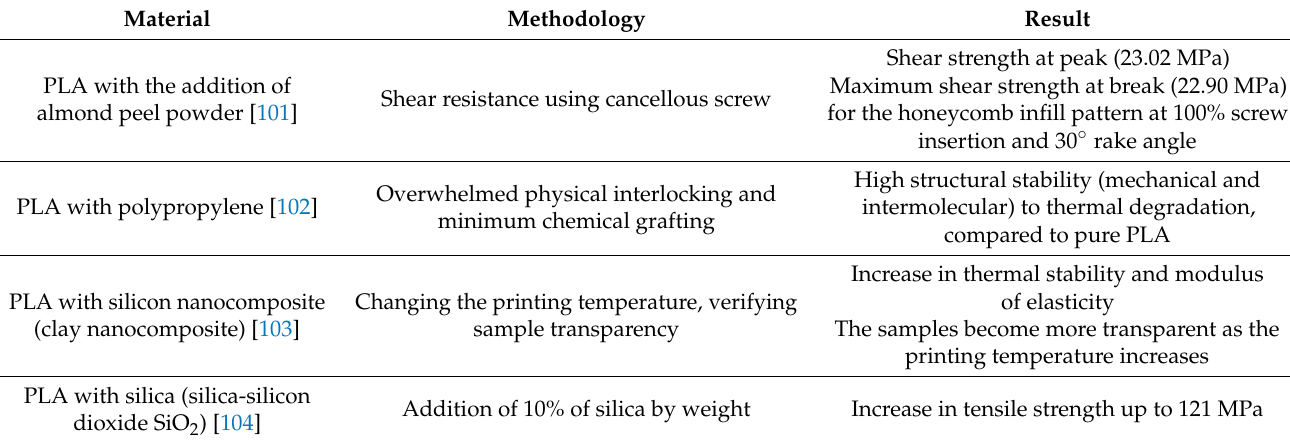
Table 2. Summary of information on selected modified